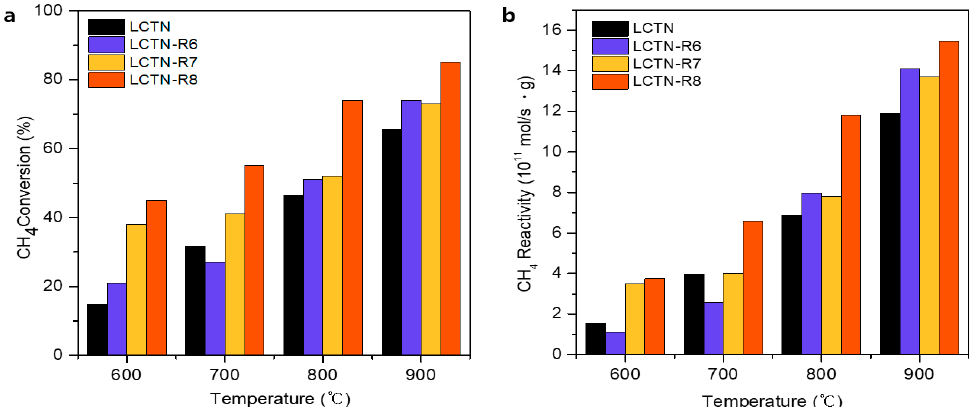
Figure 5. ( a ) CH 4 conversion and ( b ) CH 4 reactivity for H 2 production rate.